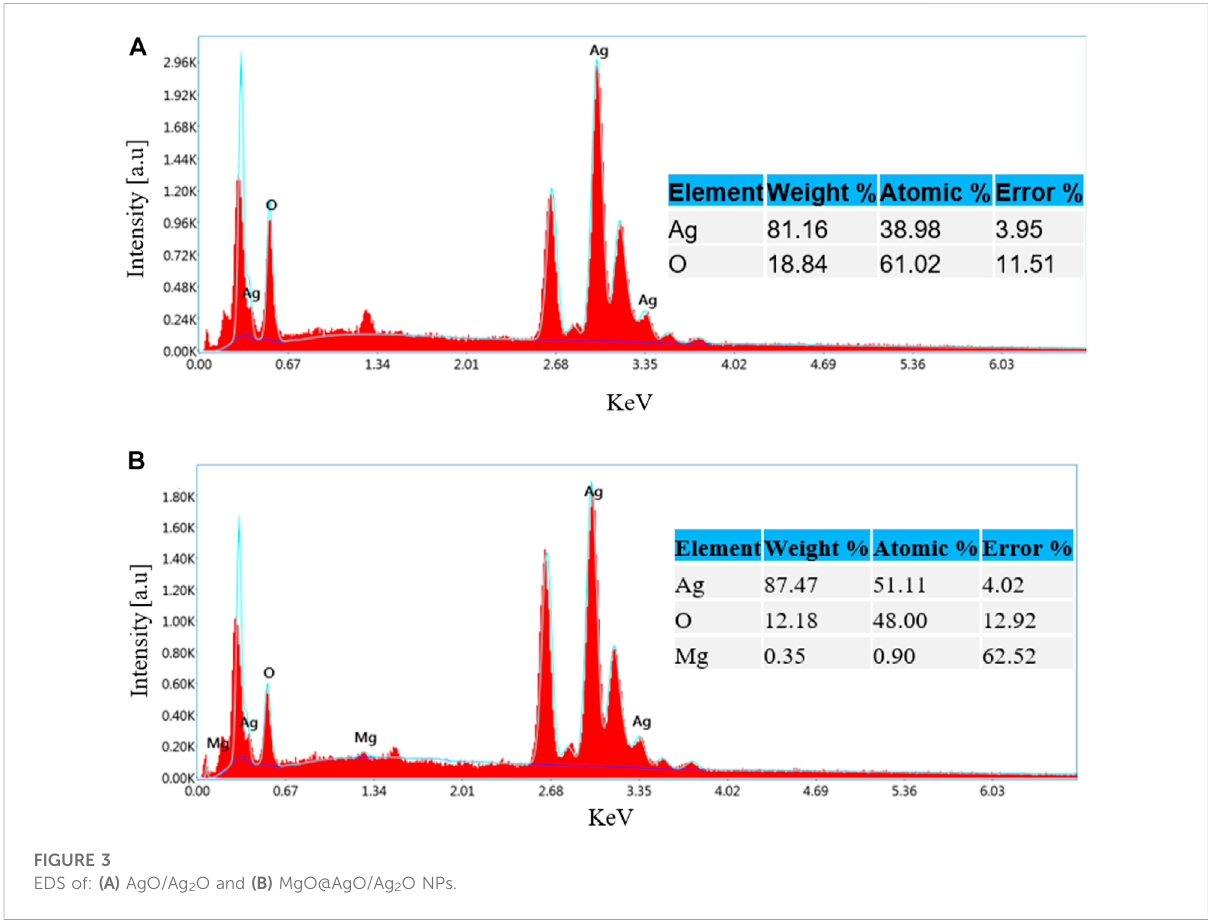
FIGURE 3 EDS of: (A) AgO/Ag 2 O and (B) MgO@AgO/Ag 2 O NPs.